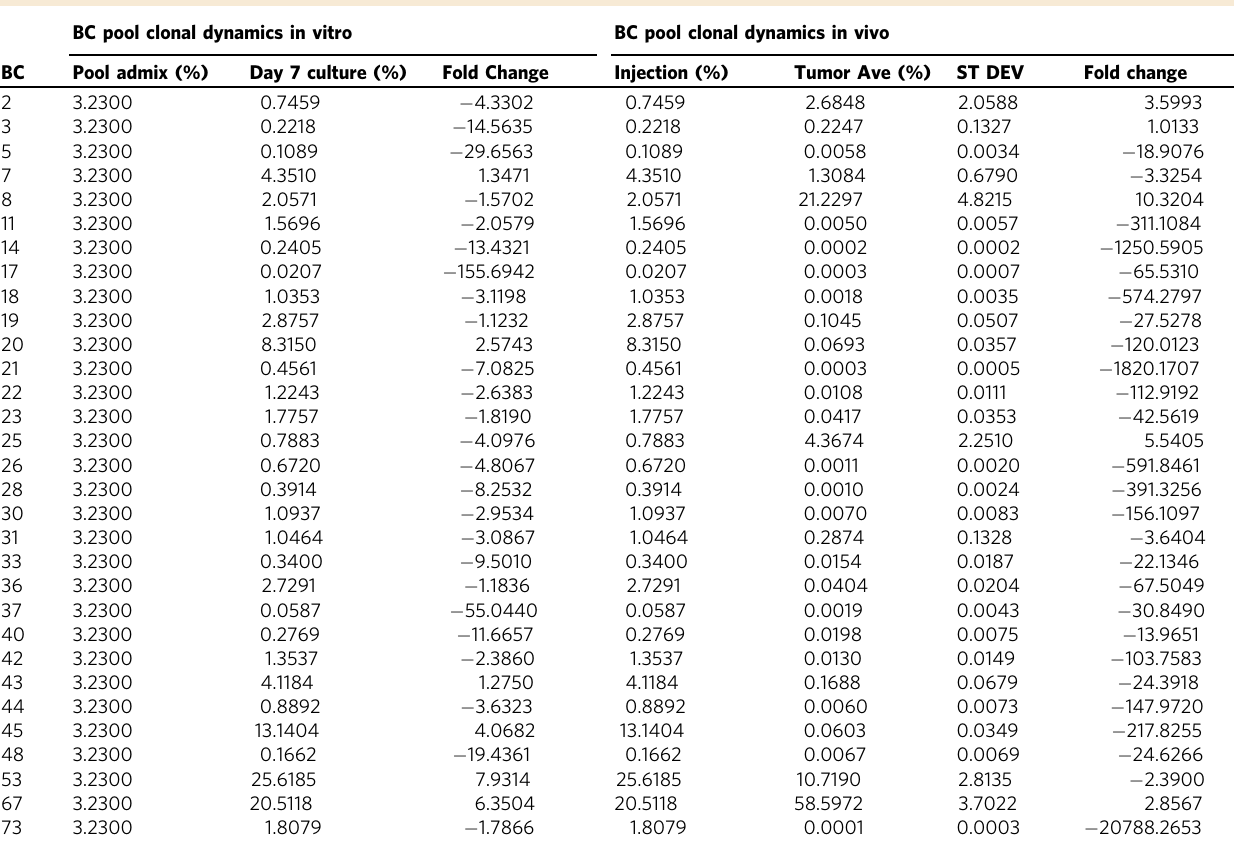
Table 1 Met1 BC composition and clonal dynamics in vitro and in vivo. BC pool clonal dynamics in